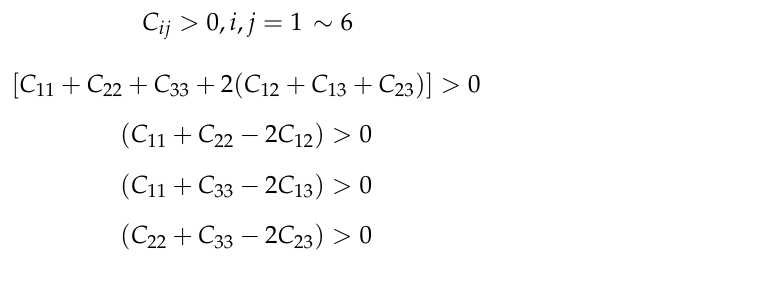
Table 2. The calculated elastic constants (GPa) and elastic modulus (GPa) within GGA level of Pnma -BN, Pbca -BN, and